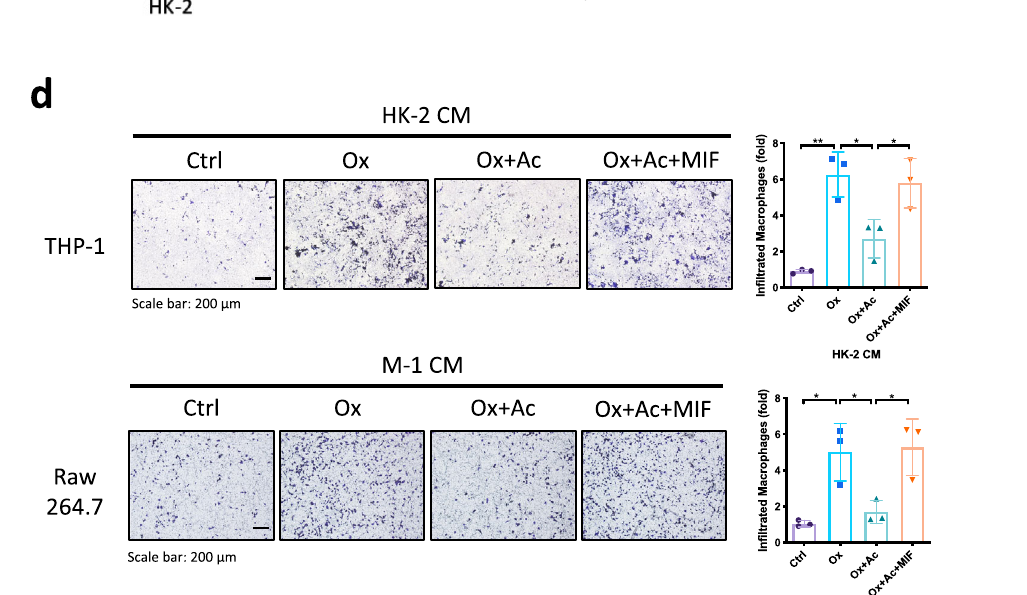
Fig. 3 Acetate inhibits macrophage recruitment via modulating the MIF signals. a Cytokine assay of different CM from HK-2 cells. CM of HK-2 treated with/without acetate were collected after 24 h incubation. MIF showed the most obvious decrease in CM from HK-2 treated with acetate (yellow squares). b The level of MIF in the CM of renal tubular cells was detected by ELISA. c Immunostaining of MIF in kidney sections of each group of rats. n = 6 for each group. d Treatment of recombinant MIF in renal epithelial cells could partially reverse the acetate-decreased M Φ s recruitment. * P < 0.05, ** P < 0.01.